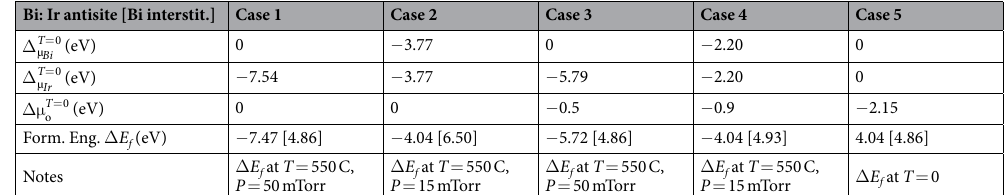
Table 1. Calculated formation energies Δ E f of a single Bi Ir defect and a Bi int in the pyrochlore structure of Bi- 0 at T = 0 in five different T 0 T 0 , ∆ = , and ∆µ = T 227 with the chemical potential differences of Bi, Ir, and O, ∆ = µ µ o Bi Ir cases. The un-bracketed (bracketed) numbers are the formation energies of the Bi Ir (Bi int ) defect. Here the 0 and ∆µ = T 0 is − 7.54 eV, and the minimum value of ∆µ = T 0 is − 2.15 eV, minimum value of both ∆µ = T Bi Ir o considering the zero-temperature DFT-calculated Bi-227 formation enthalpy per unit (consisting of 2 Bi, 2 Ir, and 7 O atoms) to be − 15.08 eV. For the calculation of Δ E f , the temperature and oxygen pressure dependence of Δ µ O was included except for Case